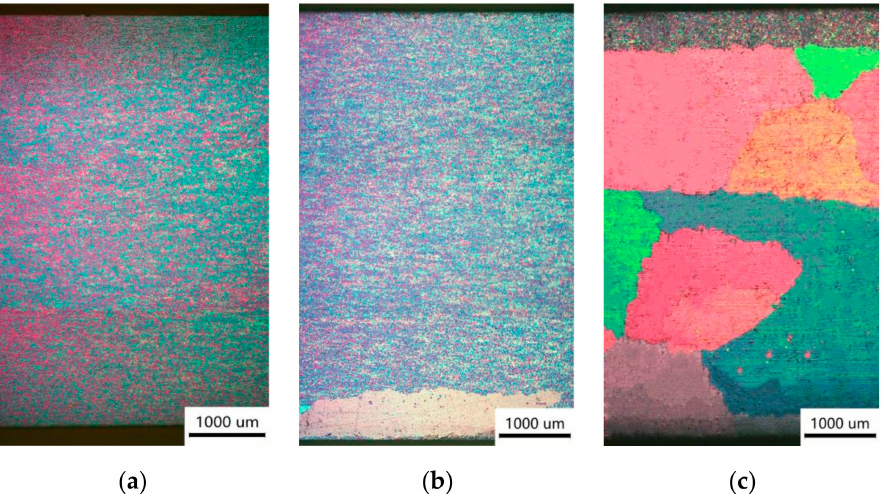
Figure 5. The polarized-light microstructure of as-drawn state 5056 aluminum alloy wires after thermal insulation at 530 ◦ C for different durations: ( a ) 10 min; ( b ) 20 min; ( c ) 60